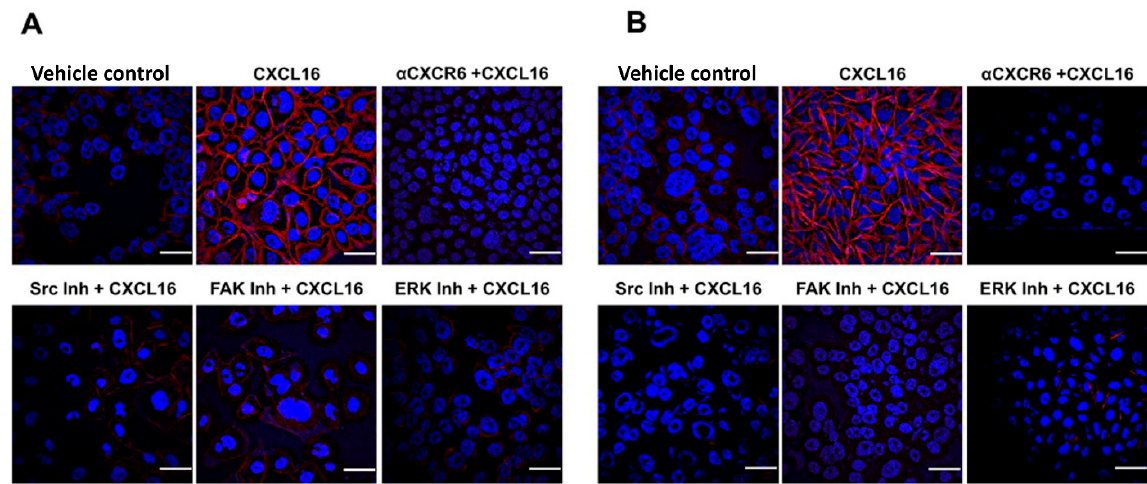
Figure 5. CXCR6 signaling promotes F-actin polymerization in breast cancer cells. Immunofluorescent images show FITC-phalloidin in CXCL16-treated MCF-7 (Panel ( A )) and MBA-MD-231 (Panel ( B )) cells. The cells were stained with DAPI to visualize nuclei (blue), and actin was probed with rhodamine-phalloidin (red). Stimulation with CXCL16 increases F-actin polymerization, which was repressed with an anti-CXCR6 antibody. Actin polymerization was significantly reduced by the inhibition of Src, FAK, and ERK1/2. Images with a 20-micron scale bar were captured at 20X magnification and represent three independent experiments (n = 3).